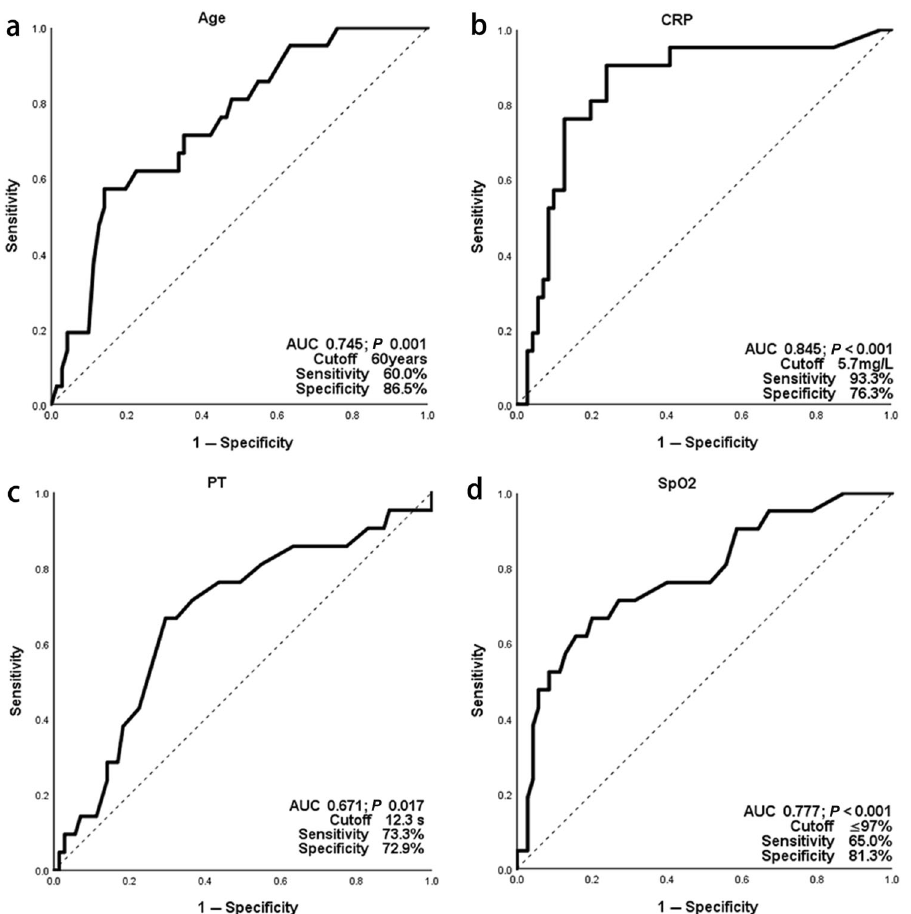
Fig. 1 Receiver operating characteristic curves to identify cut-offs of co-variates on admission in patients with mild/moderate SARS-CoV- 2-infection. These four co-variates were entering the fi nal model and shown here, other co-variates were shown in Supplementary Fig. 1. a Age; b CRP; c PT; d SpO 2 . CRP c-reactive protein, PT prothrombin time, SpO 2 blood oxygen